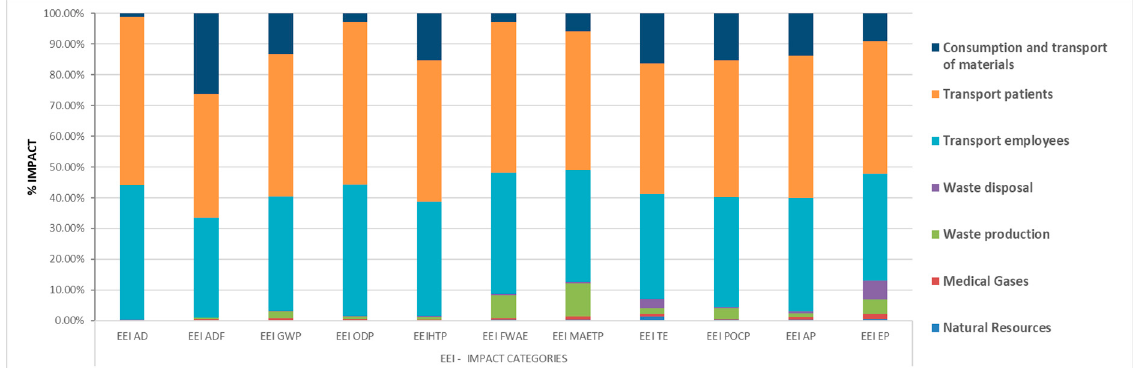
Figure 4. Distribution of the environmental impact of each environmental aspect in the global environmental efficiency indices.